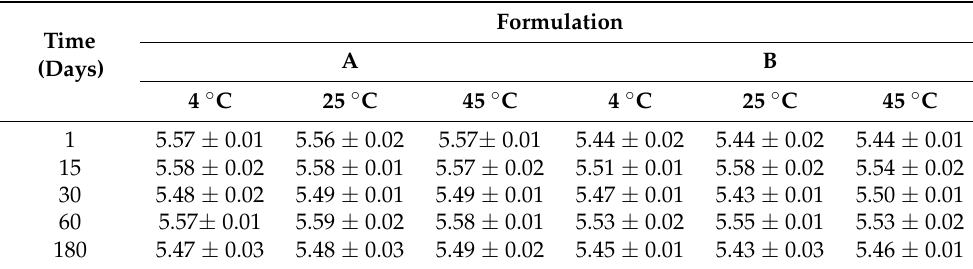
Table 3. pH values of formulations A (blank) and B (CSE-loaded) from 24 h to 6 months after preparation at different storage